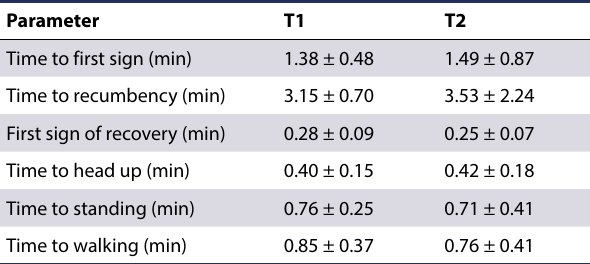
Table II: The induction and recovery times of blesbok when darted with T1 (etorphine + azaperone) and T2 (etorphine + midazolam) Parameter T1 T2 Time to first sign